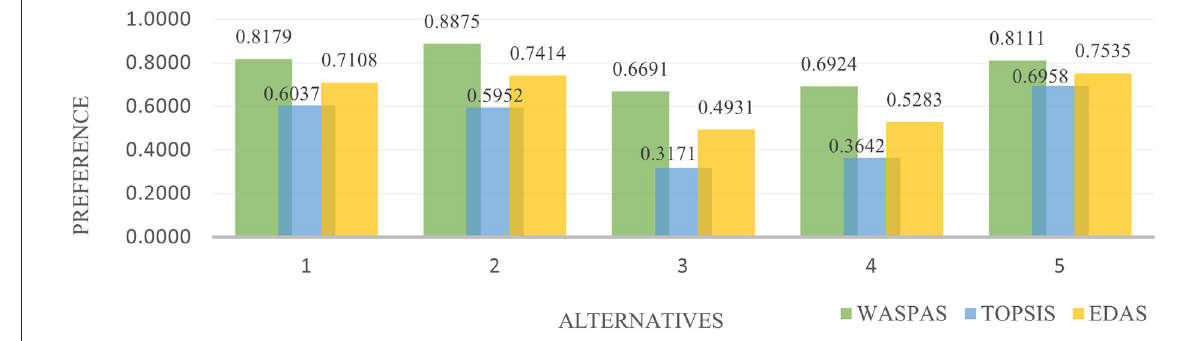
Fig 3. The comparative analysis of the hybrid BWM-CRITIC-WASPAS method with TOPSIS and EDAS (Source: Authors).